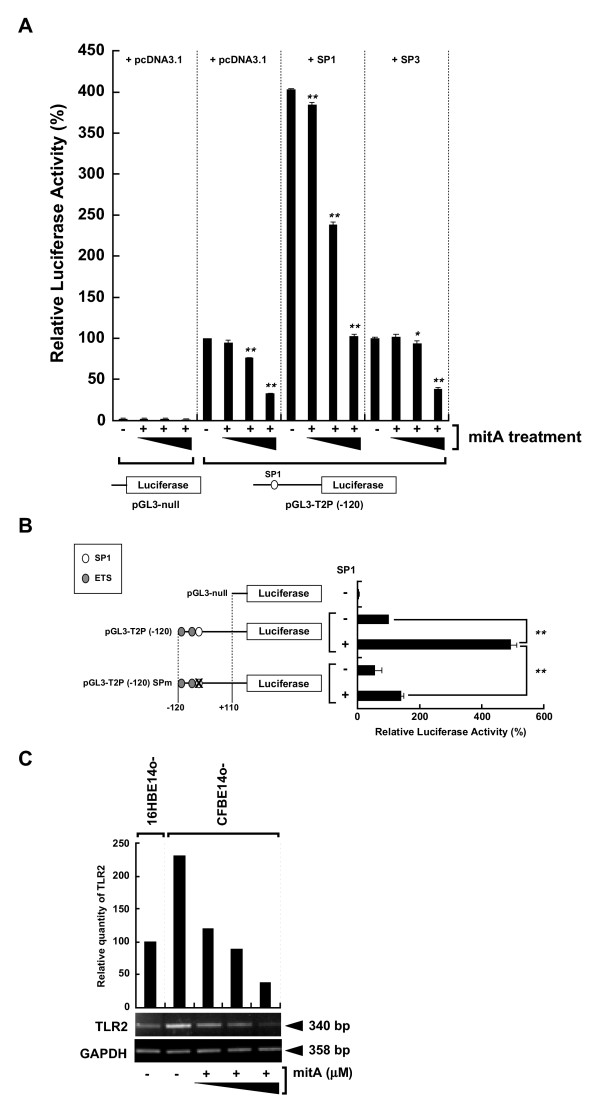
Sp1-dependent regulation of hTLR2 promoter activity and TLR2 gene expression. (A) Assessment of the effect of mithramycin A treatment on SP1-induced TLR2 promoter activation after co-transfecting HeLa cells with the pGL3-T2P (-120) or pGL3-null and with pcDNA3.1 empty vector the SP1 or SP3 plasmids into HeLa cells. Cells were either untreated or treated 1 hr after transfection with 50 nM mithramycin A for 24 hr. Luciferase activity is expressed as the percent activity of the pGL3-T2P (-120) plasmid in pcDNA3.1-transfected, mitA-untreated cells. (B) Assessment of the effect of mutating the SP1 binding site within TLR2 -120/+110 promoter region. The pGL3-T2P (-120) or the pGL3-T2P (-120) SPm construct was co-transfected into HeLa cells with pcDNA3.1 or SP1 plasmid. The HeLa cells were also co-transfected with the pGL3-null and pcDNA3.1 plasmids as negative control. Luciferase activity is expressed as the percent activity of the pGL3-T2P (-120) construct in pcDNA3.1-co-transfected cells. Data are presented as the mean ± S.E.M. from 3 independent experiments performed in triplicate. *, p < 0.05; **, p < 0.0001 as assessed by ANOVA with Tukey-Kramer method. (C) SP1-dependent TLR2 mRNA expression in human epithelial cells. CFBE41o- cells were either treated with mitA (0.5, 1, 5 μM) for 24 hr or untreated. Semi-quantitative RT-PCR analysis was performed using the total RNA extracted from either CFBE41o- or 16HBE14o- cells. TLR2 expression was quantified by normalizing to GAPDH (control) and assayed using Image Gauge (top of the gel images). Results are representative of three independent experiments.